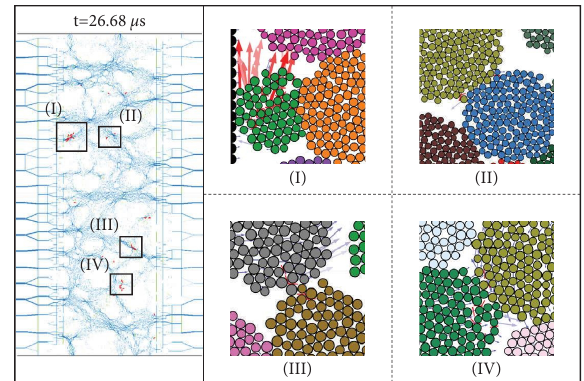
Figure 9: Breakage mode of the sand specimen during the nu- merical compression test (stage A).